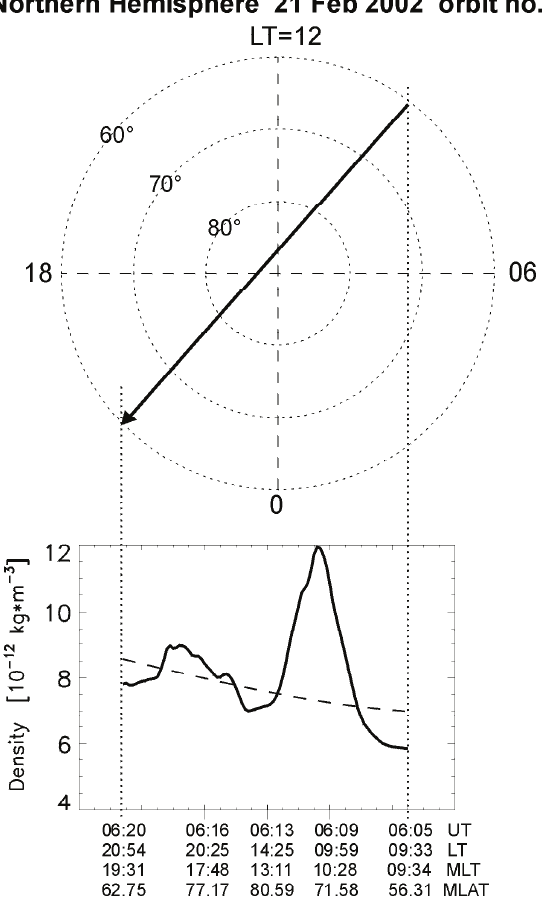
Fig. 1. Example of a CHAMP trajectory over the northern polar re- gion in a geographic latitude–local time frame. The lower panel shows the density along this trajectory as obtained from the ac- celerometer data. The dotted line indicates an average undisturbed density ρ av .